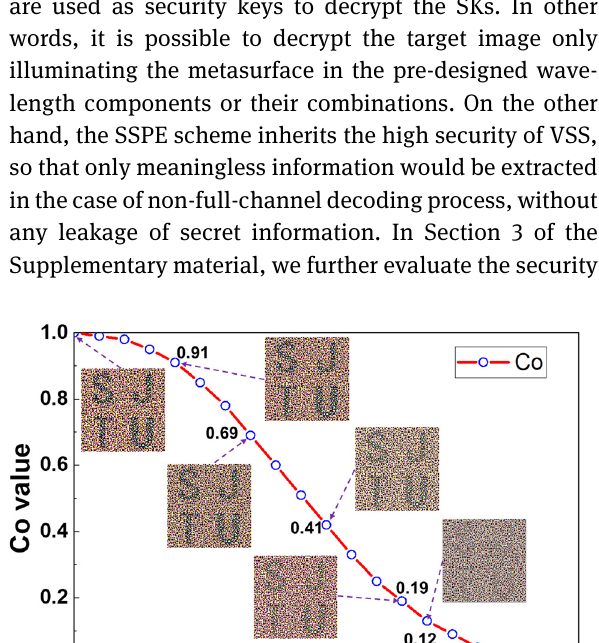
(a – c) single channel, (d – f) dual channels,